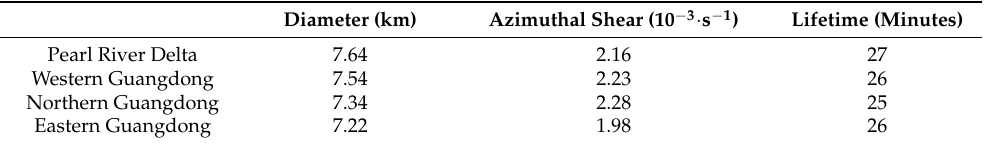
Table 3. Average diameter, azimuthal shear intensity and lifetime of the MVs in different regions of Guangdong from April to June during